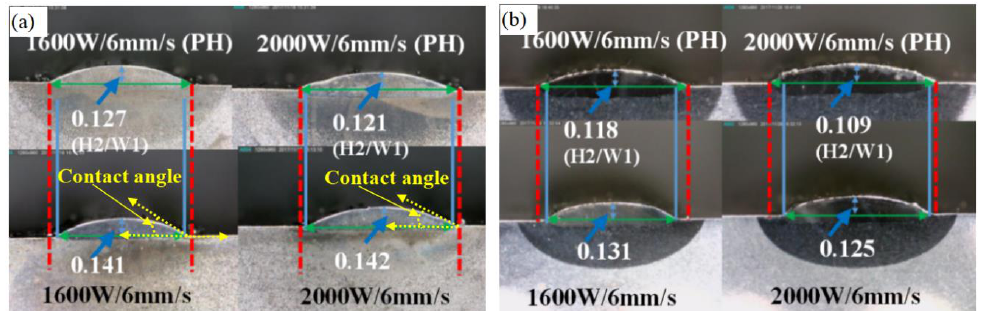
Figure 3. Morphology of laser metal deposition 316 L on 1045 steel ( a ) and P20 steel ( b ).